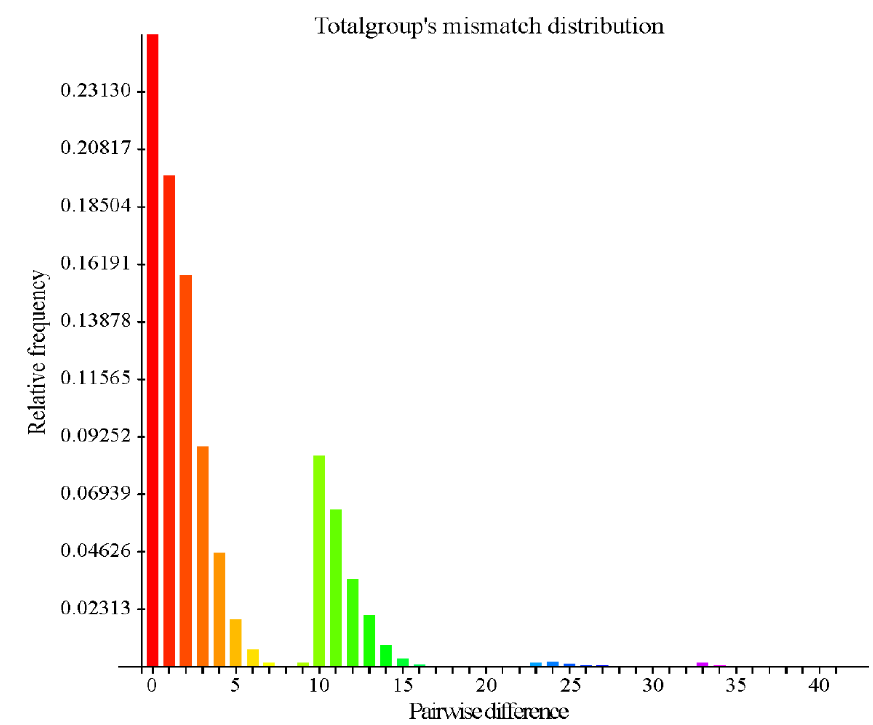
Figure 5. The mismatch distribution of the complete dataset of the MT-CYB types of Tibetan sheep of the four lineages on the Qinghai–Tibetan Plateau areas showed that there were two major peaks, with maximum values at 0 and 10 pairwise differences, and two smaller peaks at 24 and 33 pairwise differences.